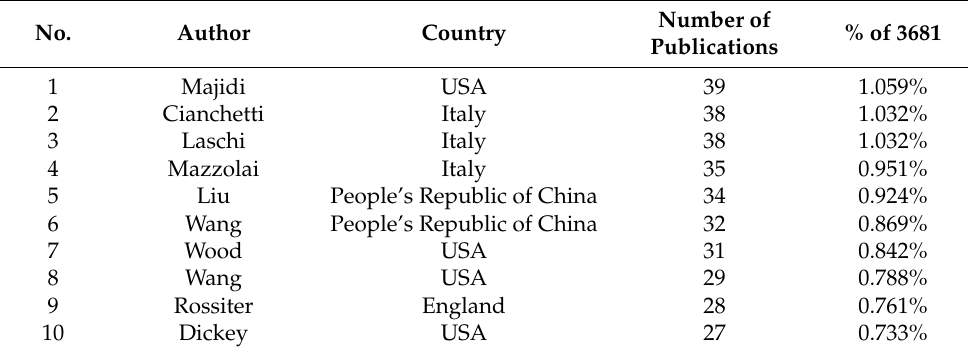
Table 5 identifies the most cited articles in the WOS database for the 2008–2022 period.